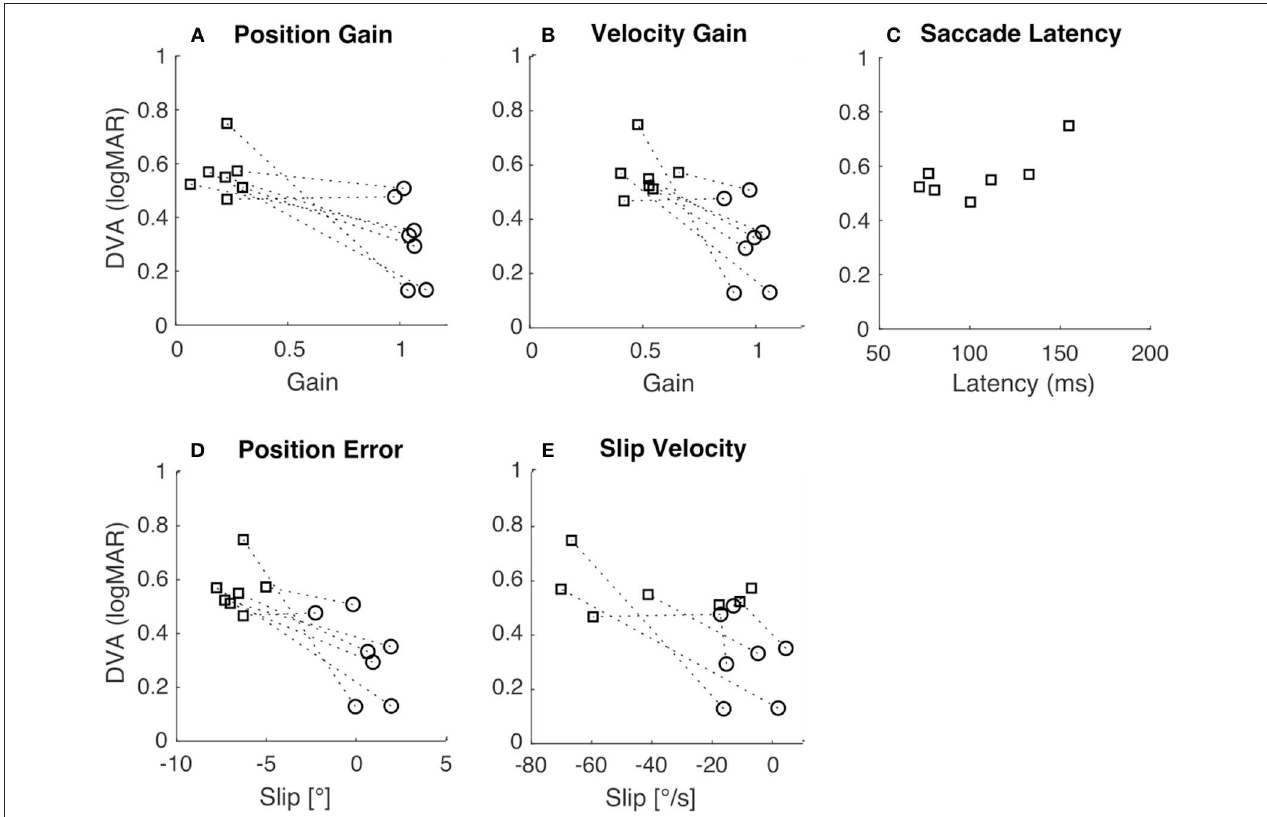
FIGURE 4 | Relation of DVA to gain, slip, and saccade latency. In all panels, squares indicate translation, circles indicate rotation, and the dashed lines connect the two data points from each subject. (A) DVA plotted vs. position gain ( R = − 0.75, p < 0.01). (B) DVA plotted vs. velocity gain ( R = − 0.73, p < 0.01). (C) DVA plotted vs. saccade latency during translation only ( R = 0.72, p = 0.07). (D) DVA plotted vs. position error ( R = − 0.77, p < 0.01). (E) DVA plotted vs. slip velocity ( R = − 0.59, p = 0.03).